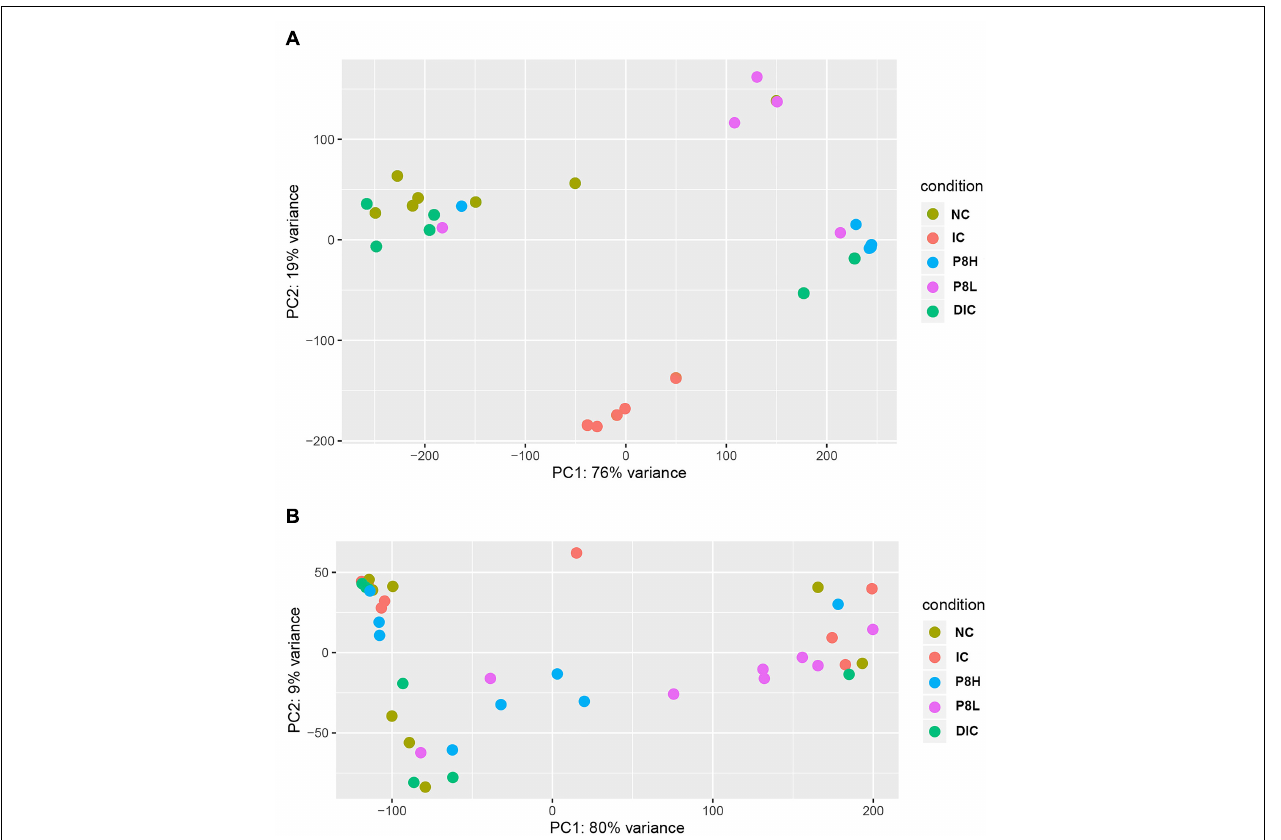
FIGURE 3 | Effects of P8 on the PCoA of gut microbiota of Eimeria -infected broilers. (A) Day 21, (B) day